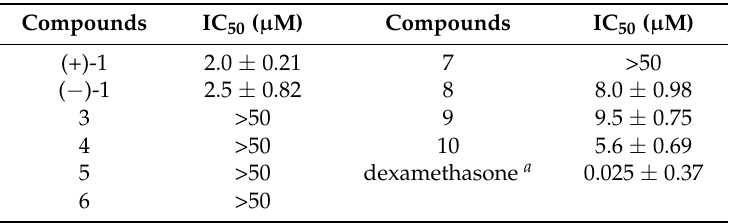
Table 3. Inhibitory effects of compounds against LPS-induced NO production in mouse macrophage cells ( n =